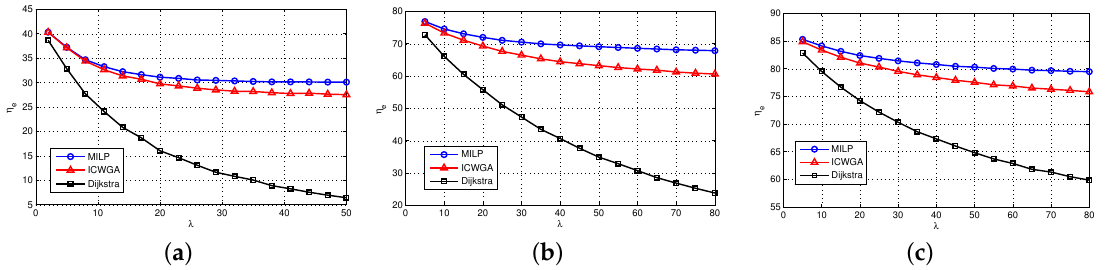
Figure 3. The results for energy saving ratio of SND-Lib topologies. ( a ) Abilene. ( b ) India. ( c ) Germany.